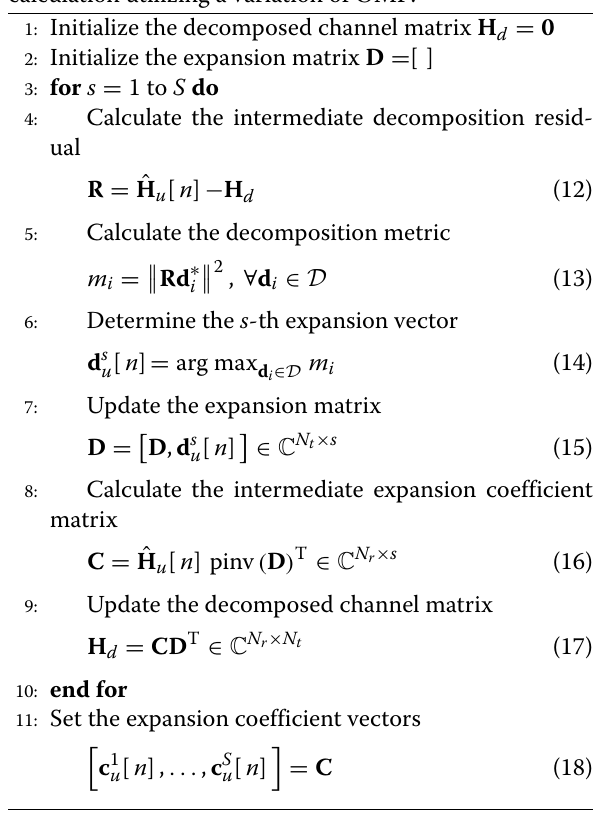
Algorithm 1 Channel decomposition for CSI feedback calculation utilizing a variation of